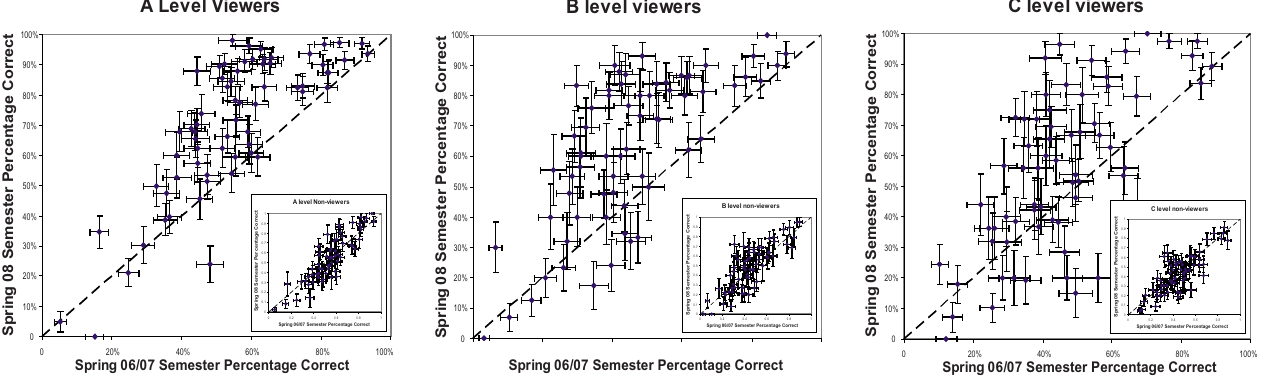
FIG. 3. (cid:1) Color (cid:2) Preflight performance of students with different levels of background knowledge. Shown in graphs A, B, and C are the preflight performance data of A, B, and C level viewers, respectively. The x and y axis have the same meaning as in Figs. 1 and 2, while the x and y values of each point is obtained from students within each level. The same data for nonviewers are plotted in the insets.